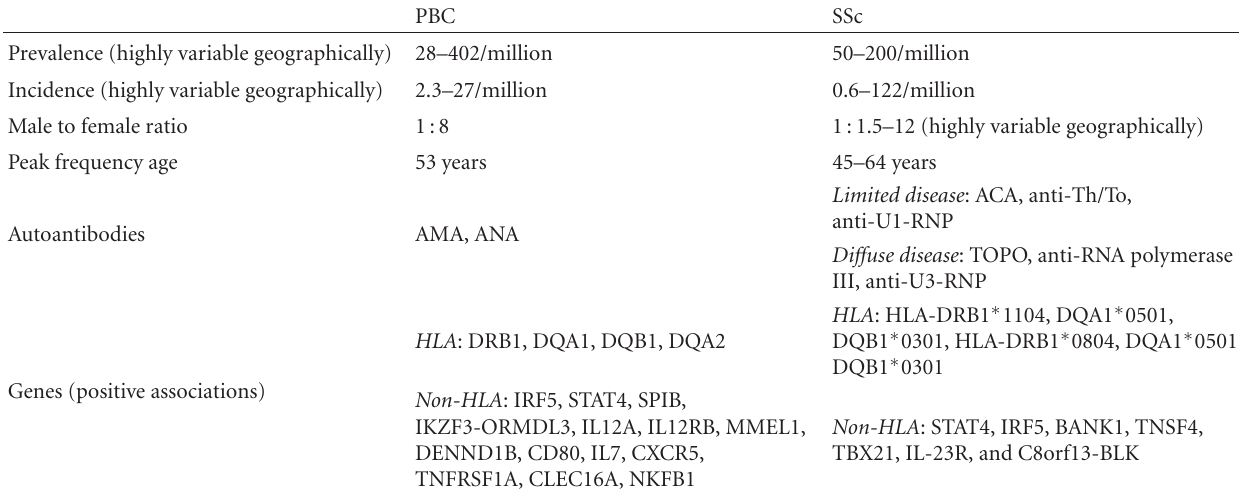
Table 1: Features demographic, immunological and genetic features of primary biliary cirrhosis (PBC) and systemic sclerosis (SSc). PBC